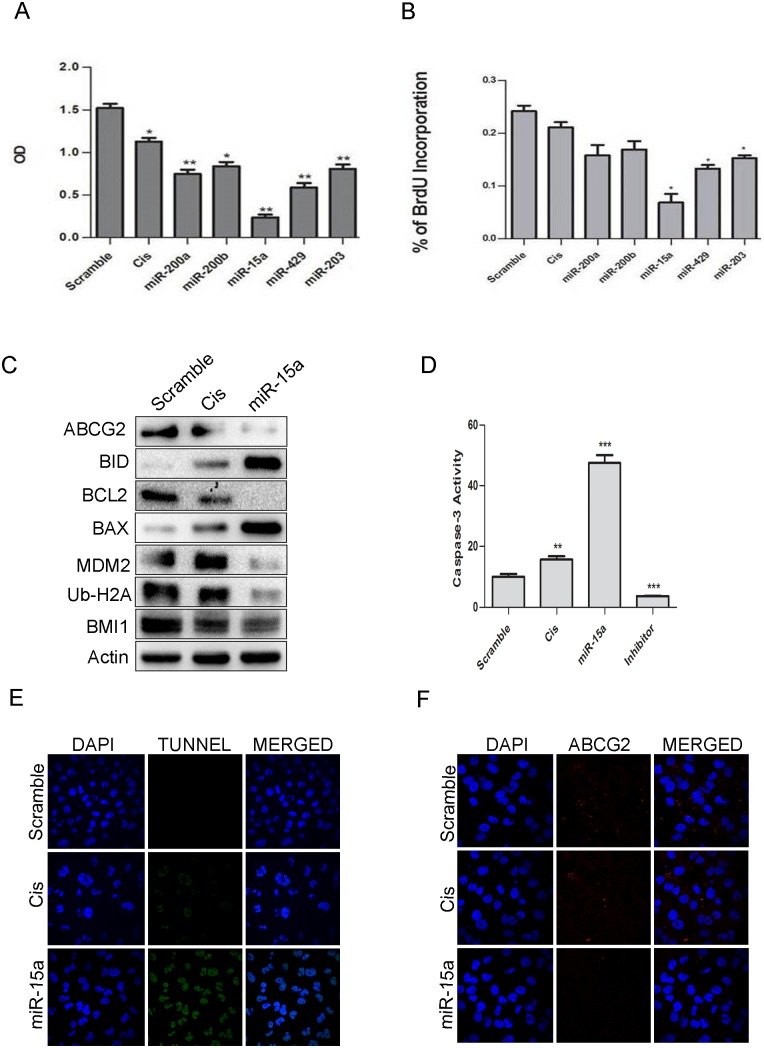
miR-15a sensitized MDAMB-231 cells to cisplatin.Results of MTT assay showing the effect of miR-200a, miR-200b, miR-15a, miR-429, miR-203 in MDAMB-231 cells. Scramble miRNA vector was used as a control. Error bars indicate ±S.E of n = 3 (A). Results of BrdU assay showing the effect of miR-200a, miR-200b, miR-15a, miR-429, miR-203 in MDAMB-231 cells. Scramble miRNA vector was used as control. Error bars indicate ±S.E of n = 3 (B). Western blot analysis showing expression of BMI1, Ub-H2A, ABCG2, MDM2, pro-apoptotic and anti-apoptotic proteins like BAX, BID, BCL2, Caspase-3 in miR-15a overexpressed cells with cisplatin treatment. Scramble miRNA transfected cells served as control. β-Actin was used as gel loading control (C). Caspase-3 assay and Tunel assay were performed in MDAMB-231 containing ectopically expressed miR-15a with cisplatin treatment. Scramble miRNA transfected cells served as control. Cells with only cisplatin treatment served as positive control (D, E). Immunocytochemistry studies of above group of cells showing expression of ABCG2 (F).